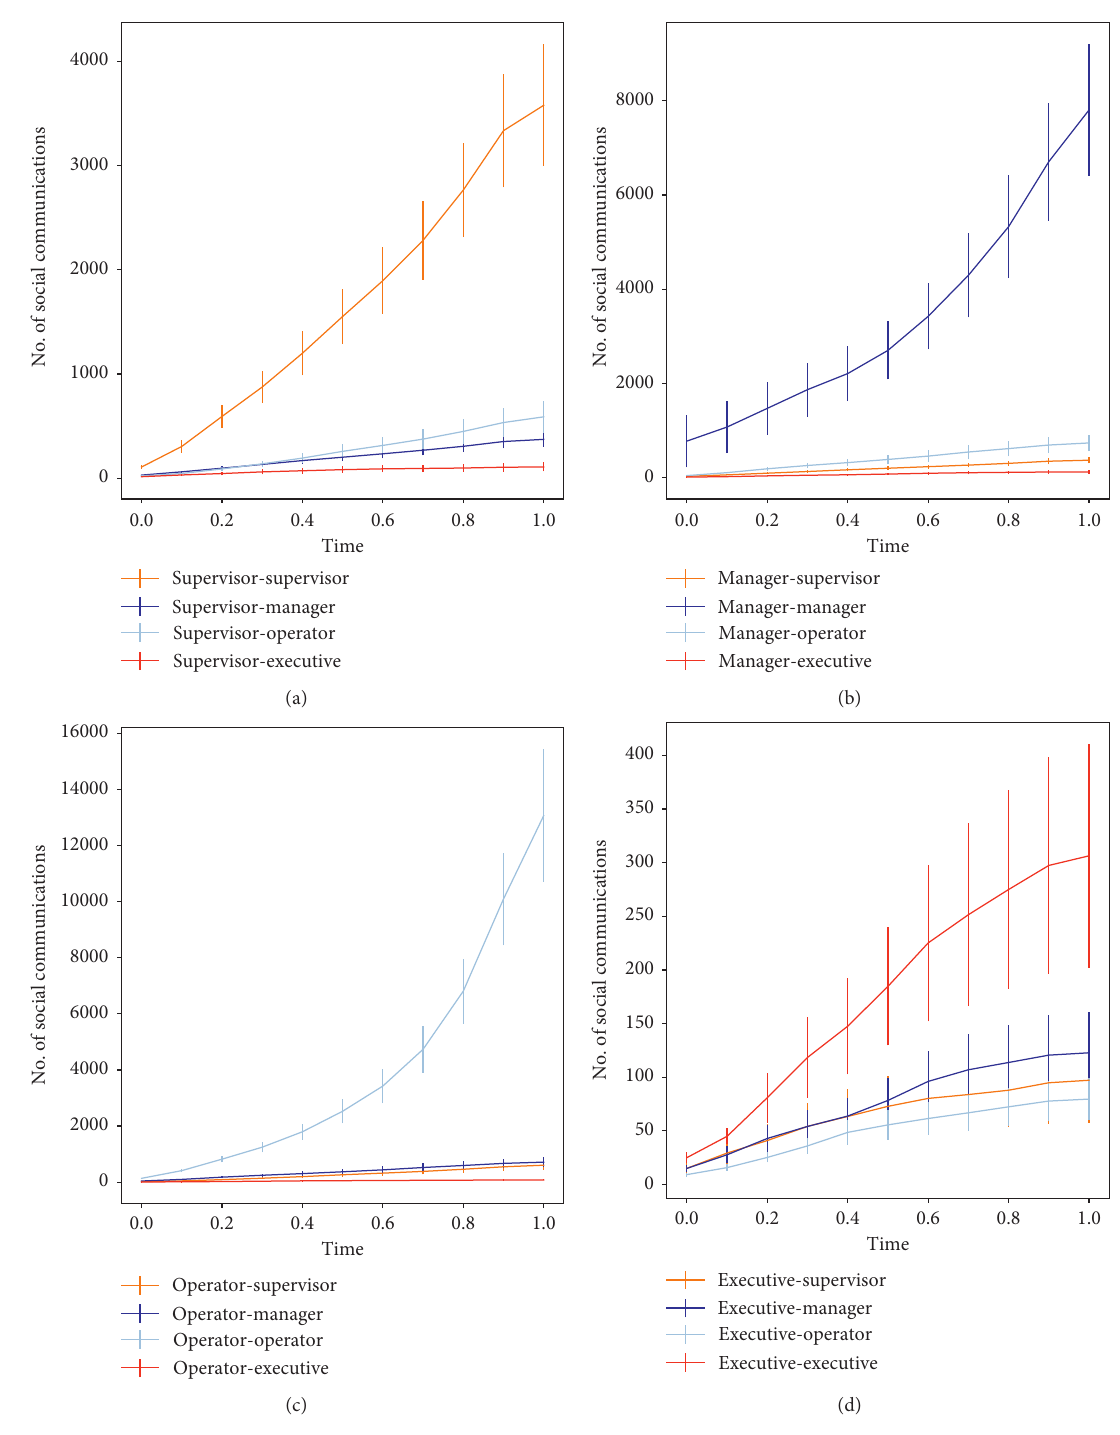
Figure 9: Average number of level-to-level communications of social networks over time for all enterprises. (a–d) Communications originated by supervisors, managers, operators, and executives, respectively. Orange, blue, light blue, and red lines show communications directed to supervisors, managers, operators, and executives, respectively. Error bars indicate the standard deviation. An analogous plot for formal communications is shown in Figure